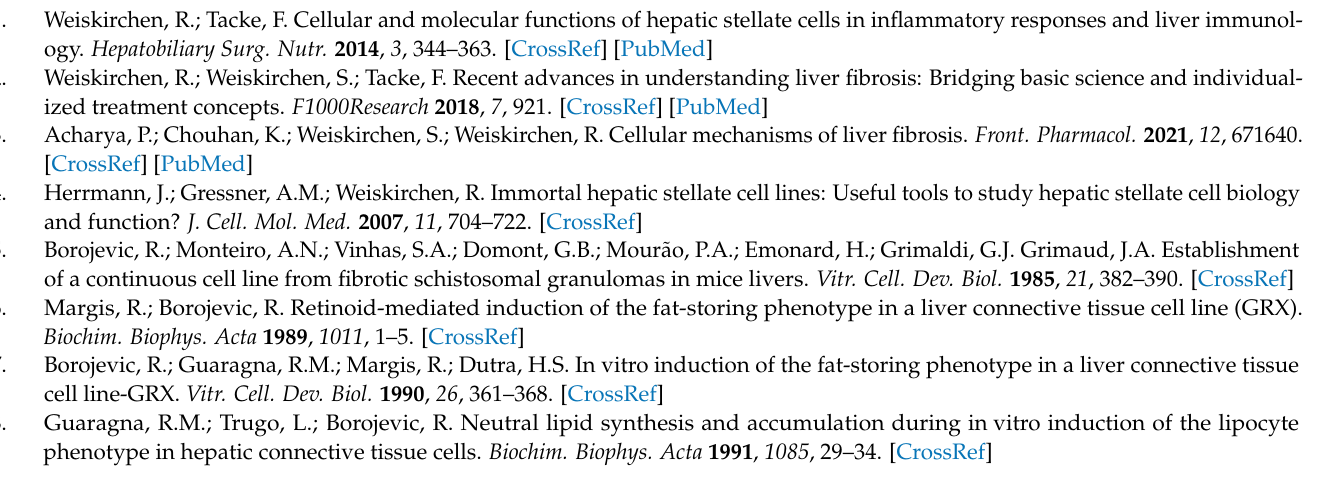
murine leukemia virus; Figure S3: Occurrence of polyploidy in GRX cells; Figure S4: Robertsonian translocations in GRX cells; Figure S5: Additional chromosomal arrangements in GRX cells; Table S1: Publications using or mentioning GRX cells; Table S2: Antibodies used in Western blot analysis; and Table S3: Overview of virus substrates used in this